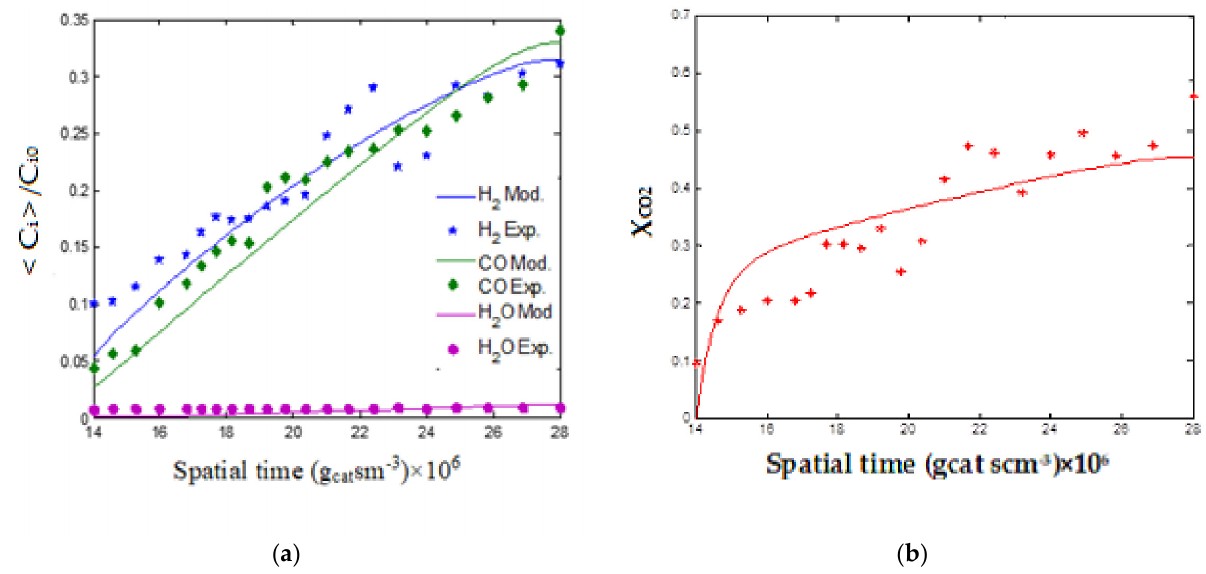
Figure 5. Evolutions of conversions as a function of space-time. ( a ) CH 4 ( b ) CO 2 . Conditions: Ni (4.86 % wt.)/ γ -Al 2 O 3 catalyst, fluidized bed (280.0 g), 1.0 bar, 973K. The evolution of the yields ( Y i = 10 2 C i (C CH40 + C CO20 ) − 1 ; i = H 2 , CO ) of hydrogen and carbon monoxide reached 47.72% and 49.95%. In Figure 6, these yields are represented as evolution in terms of synthesis gas yield ( Y syngas = 10 2 [C H2 + C CO ](C CH40 + C CO20 ) − 1 ), highlighting an increasing curve that converges to reach 97.67% of yield.